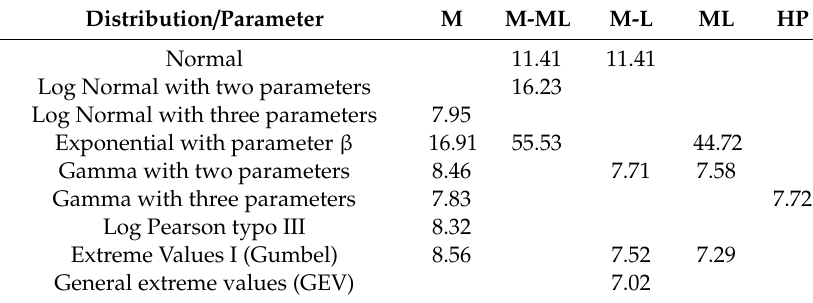
Table 1. Distribution functions with minimum adjustment error*.